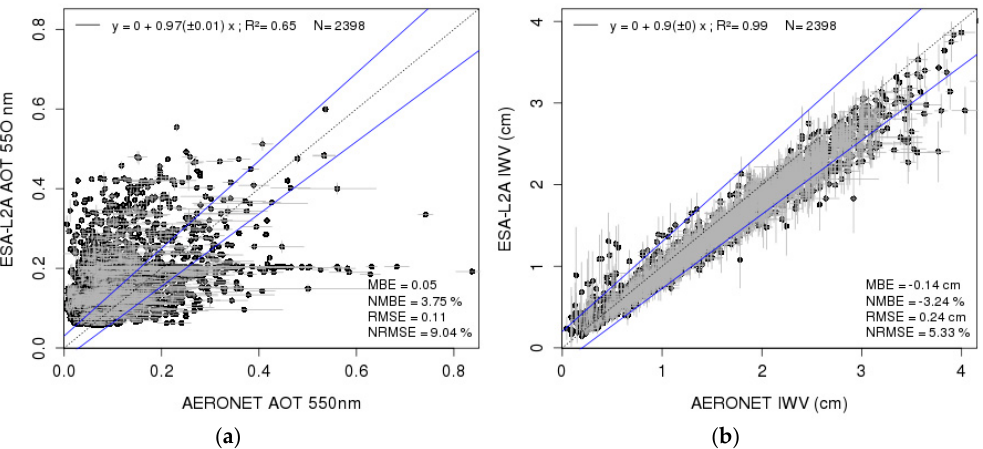
versus coincident AERONET Level 2.0 data. The dashed grey line indicates the x = y line and the solid blue lines show the accuracy requirement limits (a) | ∆ AOT 550 | ≤ 0.1 × AOT 550 ref + 0.03, and (b) | ∆ IWV | ≤ 0.1 × IWV ref + 0.2